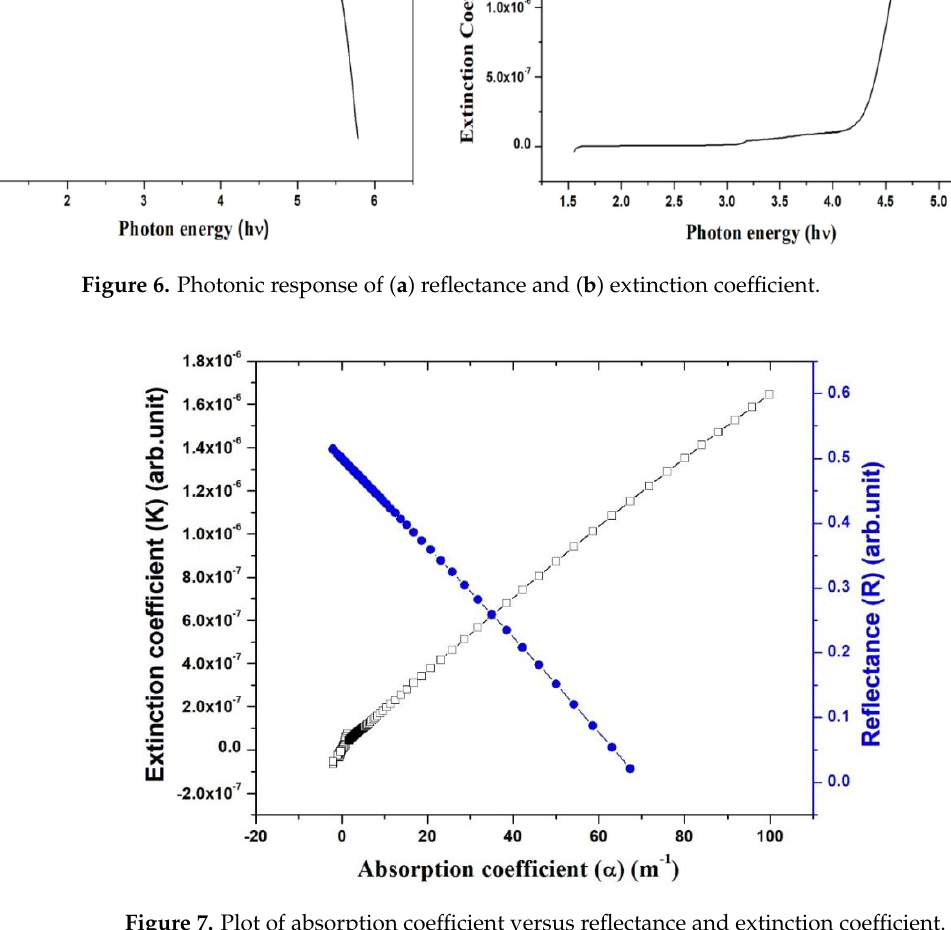
Figure 7. Plot of absorption coefficient versus reflectance and extinction coefficient.